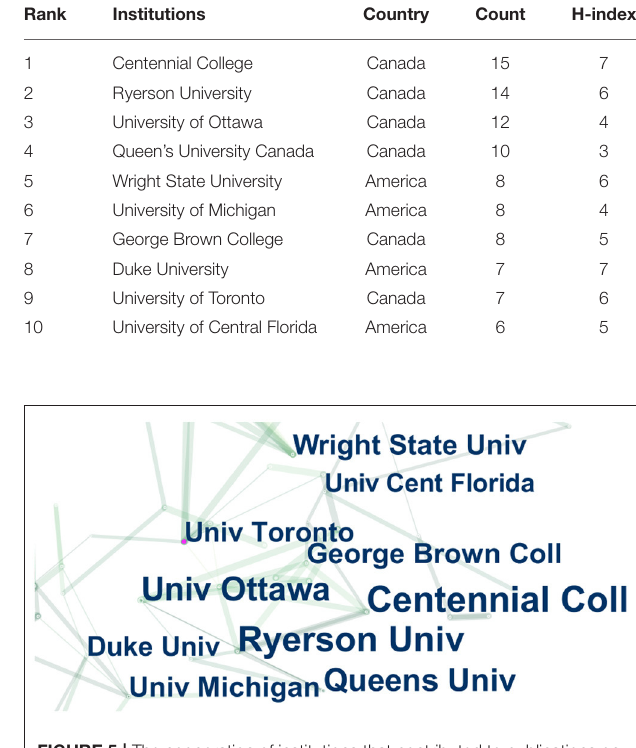
FIGURE 5 | The cooperation of institutions that contributed to publications on applying VR to the study of nursing from 2012 to 2021. Each label in the figure is a research institution. The connecting line between labels indicates the cooperative relationship between institutions.